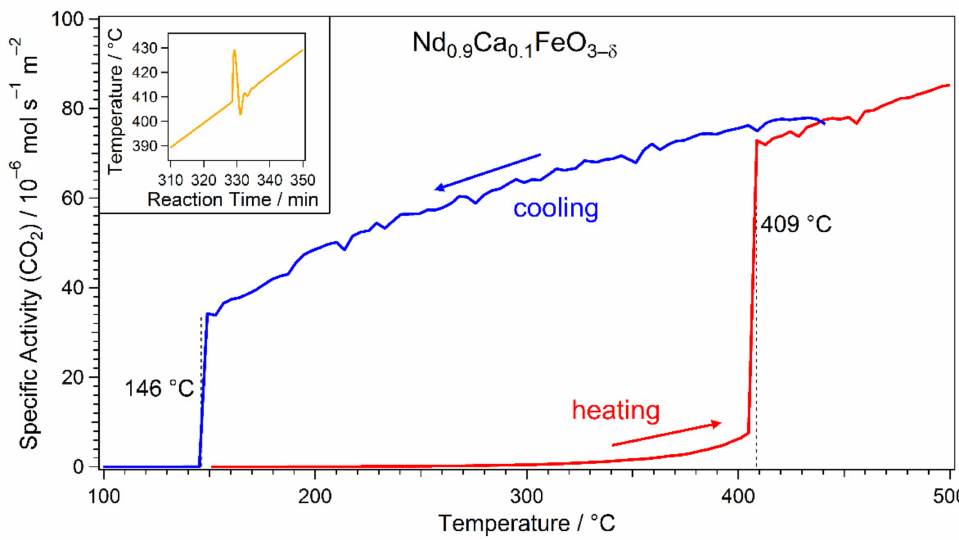
Figure 5. Hysteresis of Nd 0.9 Ca 0.1 FeO 3- δ (Nd09): Ignition (onset of significant catalytic activity) upon heating the sample (red curve) happens at 409 ◦ C, while catalytic activity persisted far below that temperature during the cooling of the sample (blue curve). For Nd06, extinction (a significant sudden drop of specific activity) was found to happen at 146 ◦ C. The inset shows an additional thermal effect that could be observed during heating: Due to the exothermic nature of CO oxidation, the temperature spikes around ignition as additional heat is released during the reaction—the peak below the target temperature immediately after this spike arose from the PID controller of the heating overcorrecting. The inverse effect was found around extinction (not